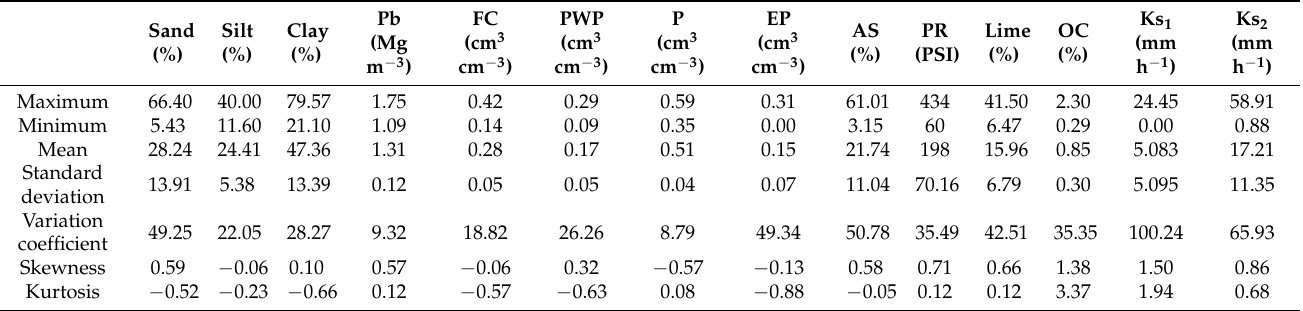
Table 4. Statistical values of the Ks and soil